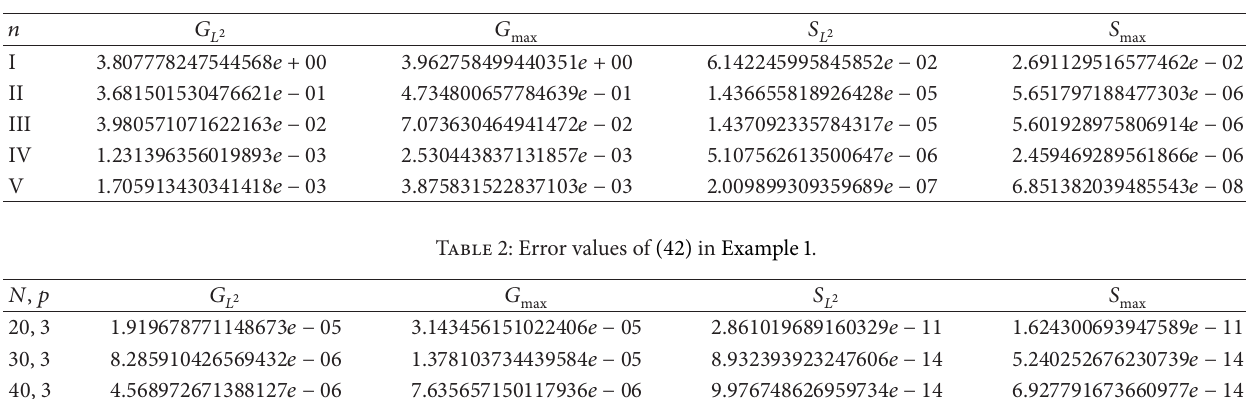
Table 1: Error values of (42) in Example 1.